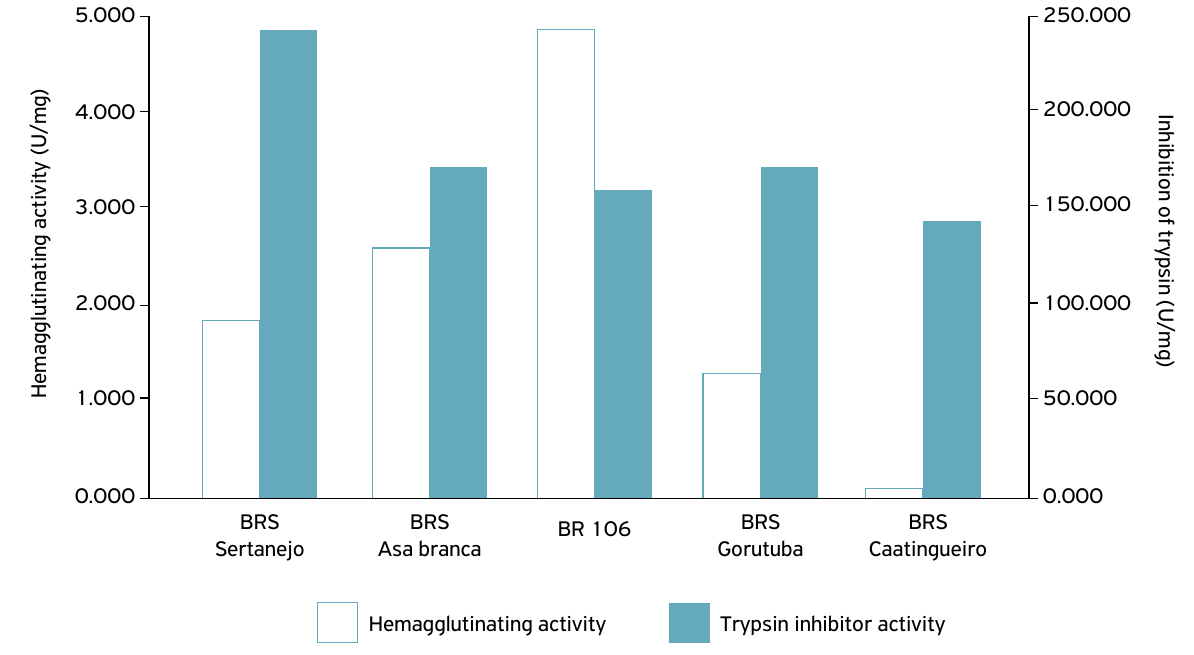
Figure 3. Hemagglutination activities and inhibition of trypsin in different maize varieties.